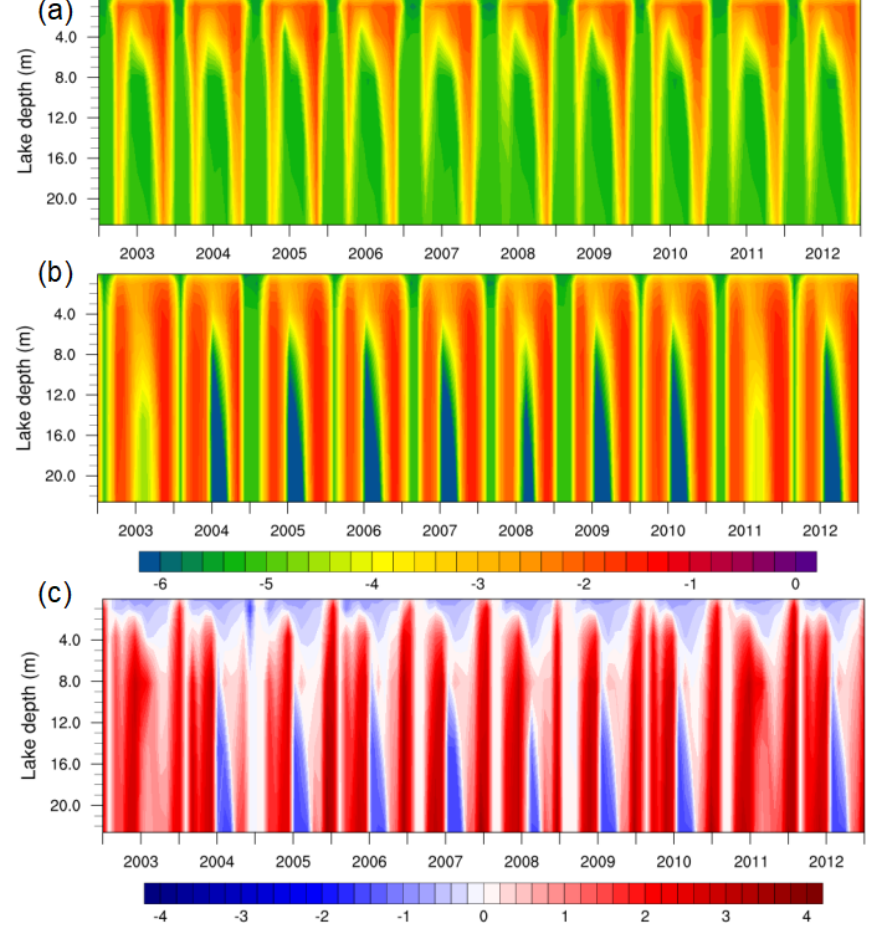
Figure 8. Simulated (a) log 10 K ORG w with CLM-ORG, (b) log 10 K KPP w with CLM-KPP (unit: m 2 s − 1 ) averaged over water columns with depth greater than 25m (28 of 34 grid cells), and (c) differences between log 10 K KPP w and log 10 K ORG w (log 10 K KPP w − log 10 K ORG w